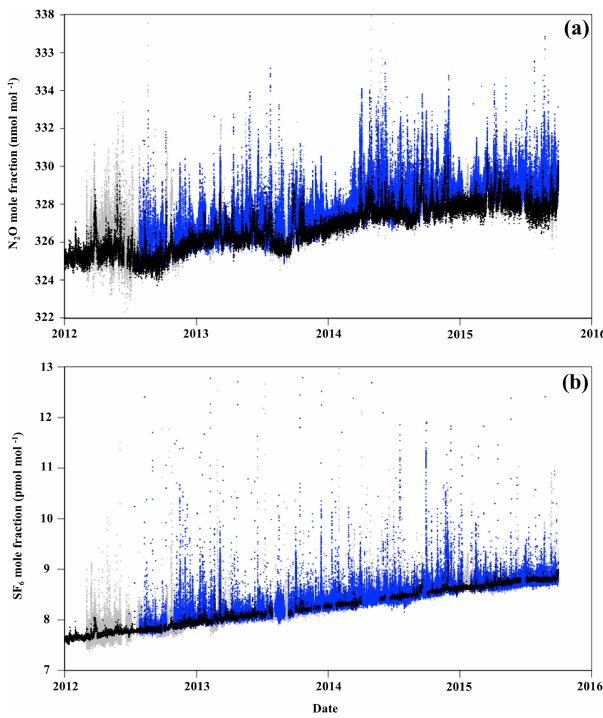
Figure 6. Time series of (a) CO 2 and (b) CH 4 mole fractions at MHD (black; 10m inlet) RGL (grey; 90m inlet), TTA (red; 222m inlet) and TAC (blue; 100m inlet) from 1 January 2012 to 30 September 2015. Results shown are hourly averages. CO 2 results shown are inµmolmol − 1 and are on the WMO-X2007 scale. CH 4 results are shown in nmolmol − 1 and are on the WMO-X2004A scale.